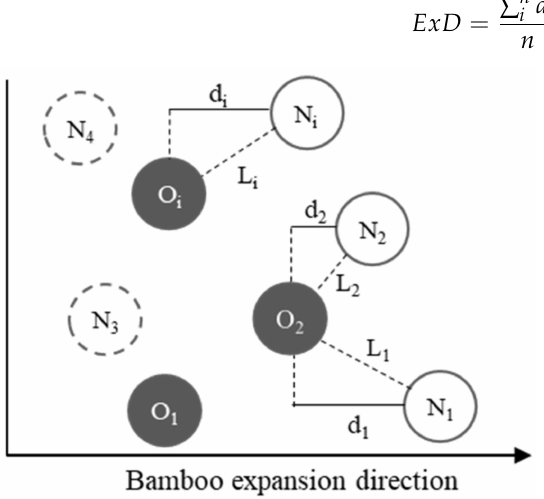
Figure 2. The calculation of expansion distance ( ExD ) of moso bamboo culms in front of woodland. The white circles mean new bamboo, the black circles mean old bamboo. L is the linear distance between a new culm and its nearest old culm, and d is the horizontal distance between new bamboo and its nearest old bamboo along the expansion direction. The new bamboos in front of the nearest old bamboo (solid white circle) were considered in the calculation of ExD , and the new bamboos in the back of the nearest old bamboo (dash white circle) were